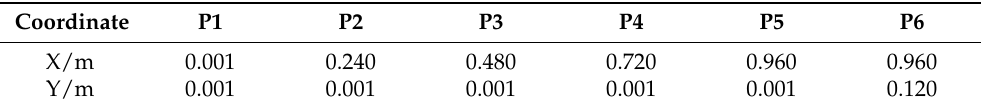
Table 2. Coordinates of monitoring point location.